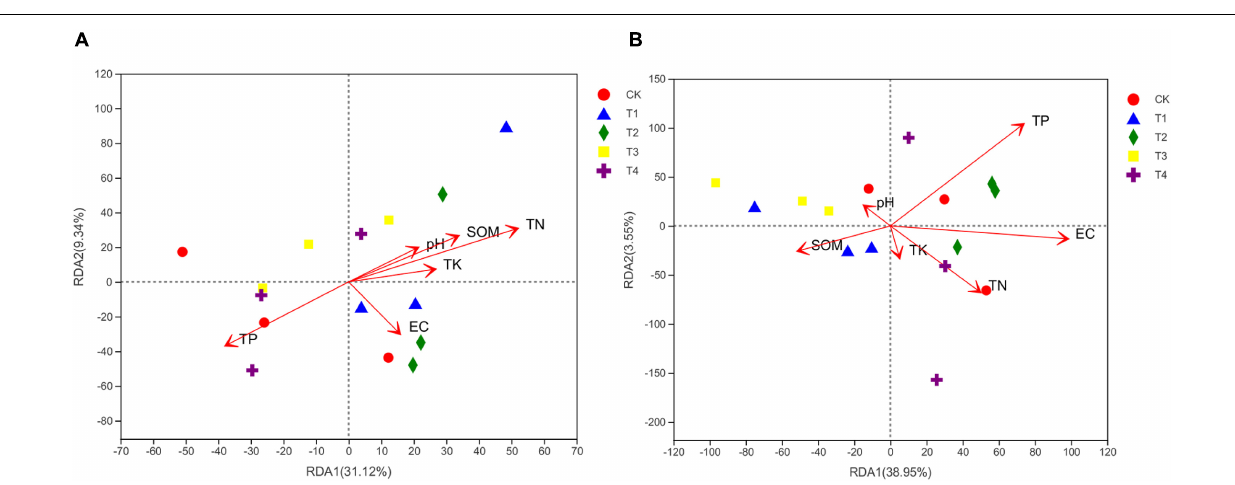
FIGURE 3 | Redundancy analysis (RDA) of bacterial (A) and fungal (B) communities with soil chemical properties. EC, electrical conductivity; SOM, soil organic matter; TN, total nitrogen; TP, total phosphorus; TK, total potassium. CK, T1, T2, T3, and T4 are as defined in the Figure 1